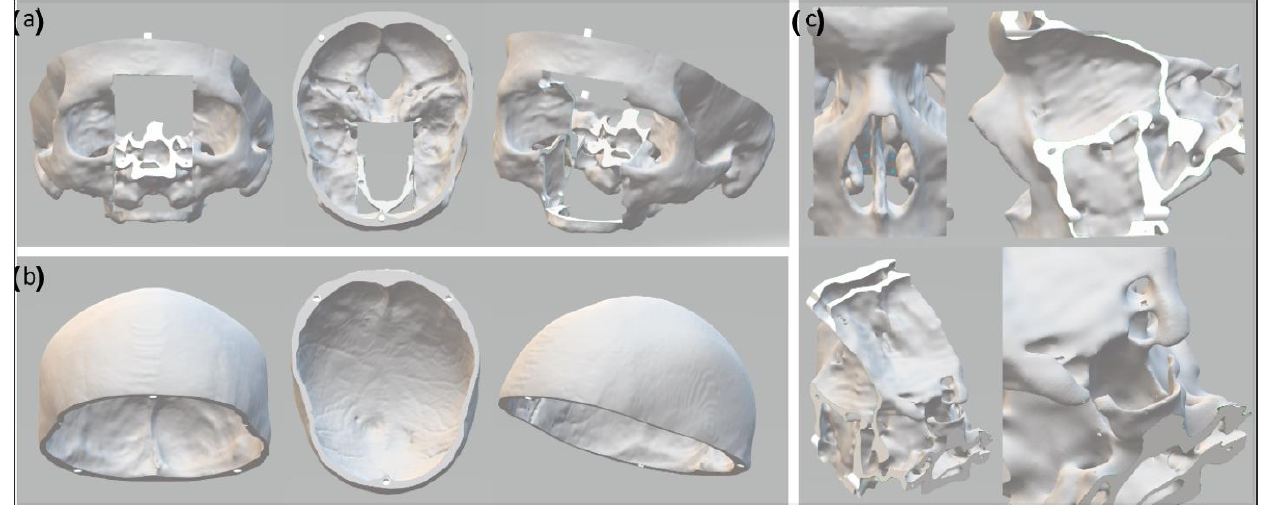
Figure 2. Computational model of the skull segmented from the CBCT image. The computation model of the skull ( a ) is modified to allow the removal of the top ( b ) for placement of the brain. The nasal cavity ( c ) is modular and can be replaced after surgical simulation.